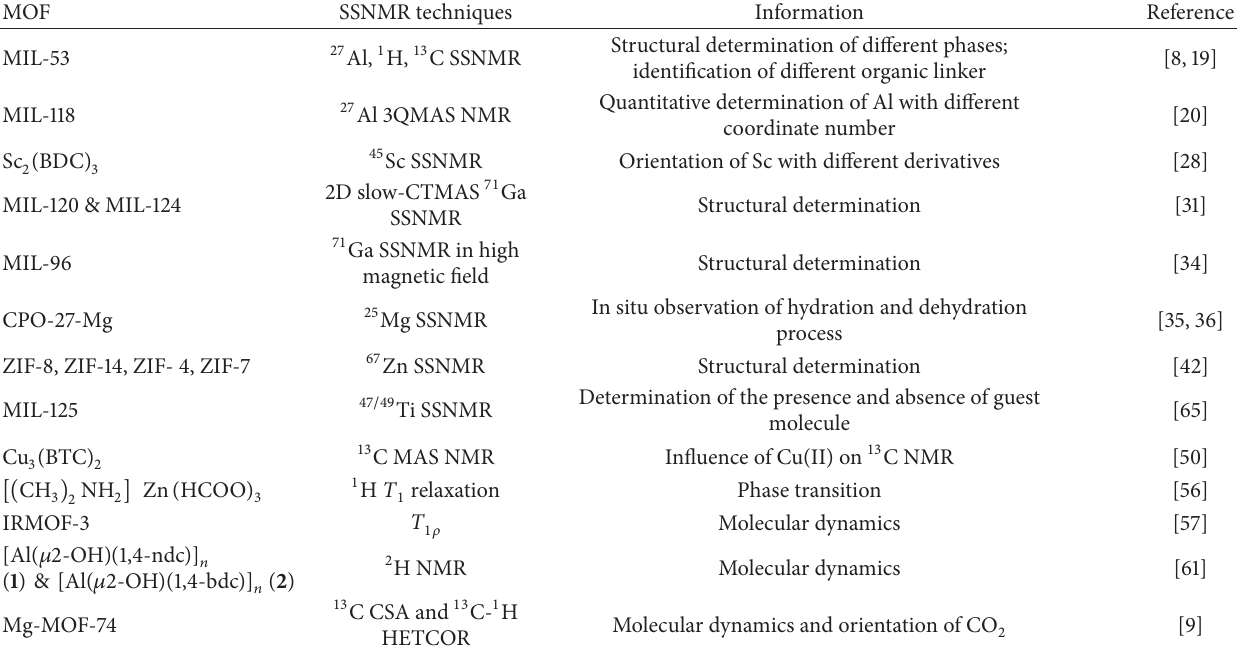
Table 2: Application of SSNMR in various MOFs with different